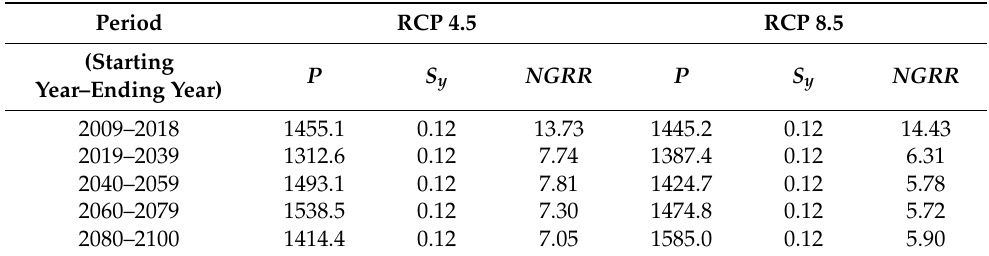
Table 4. Estimated NGRR (%), annual precipitation ( P , mm), recharge ratio ( f ), and specific yield ( S y )